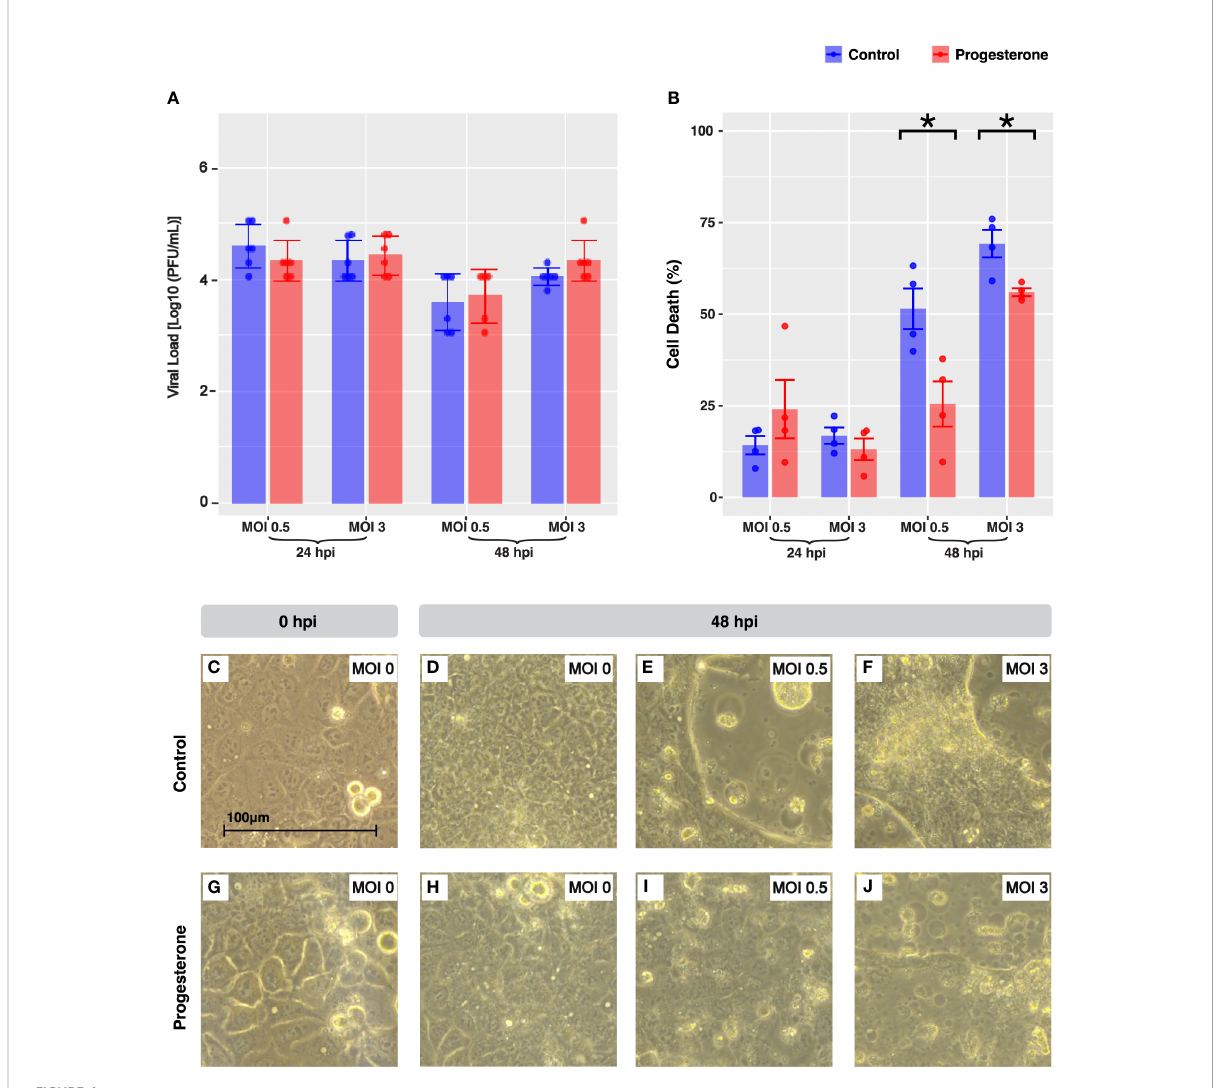
FIGURE 4 Cell death and cytopathic effect in ACH-3P, a placental cell line. IAV viral load in ACH-3P (A) . The bar plot depicts the Log10(PFU/ml) value grouped by MOI and time point. Cell death was quanti fi ed by LDH release in a subset of the experiments shown in panel A (B) . Microscope images (40X objective lens) capture representative cellular pathology in the control cells (C – F) versus the progesterone-treated cells (G – J) at 24 hours post-infection, the timepoint at which there was a signi fi cant increase in cell death due to progesterone treatment. The ACH-3P cells at 0 hours post-infection were infected with MOI 0 (C, G) . At 24 hours post-infection, cells are shown infected with MOI 0 (D, H) , MOI 0.5 (E, I) , and MOI 3 (F, J) . Blue indicates control-treated cell lines and red indicates progesterone-treated cell lines. *p-value was less than 0.05, as determined by the statistical analysis detailed in the Methods